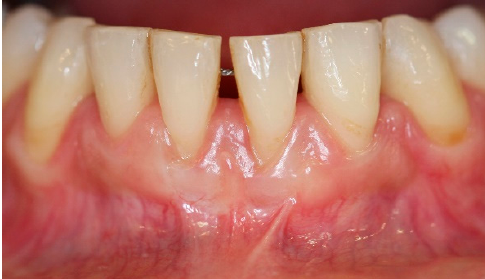
Figure 13. Two-year post-operative aspect of lower anterior area. Note improved gingival aspect, a certain degree of root coverage together with increased attached and keratinized gingival width.